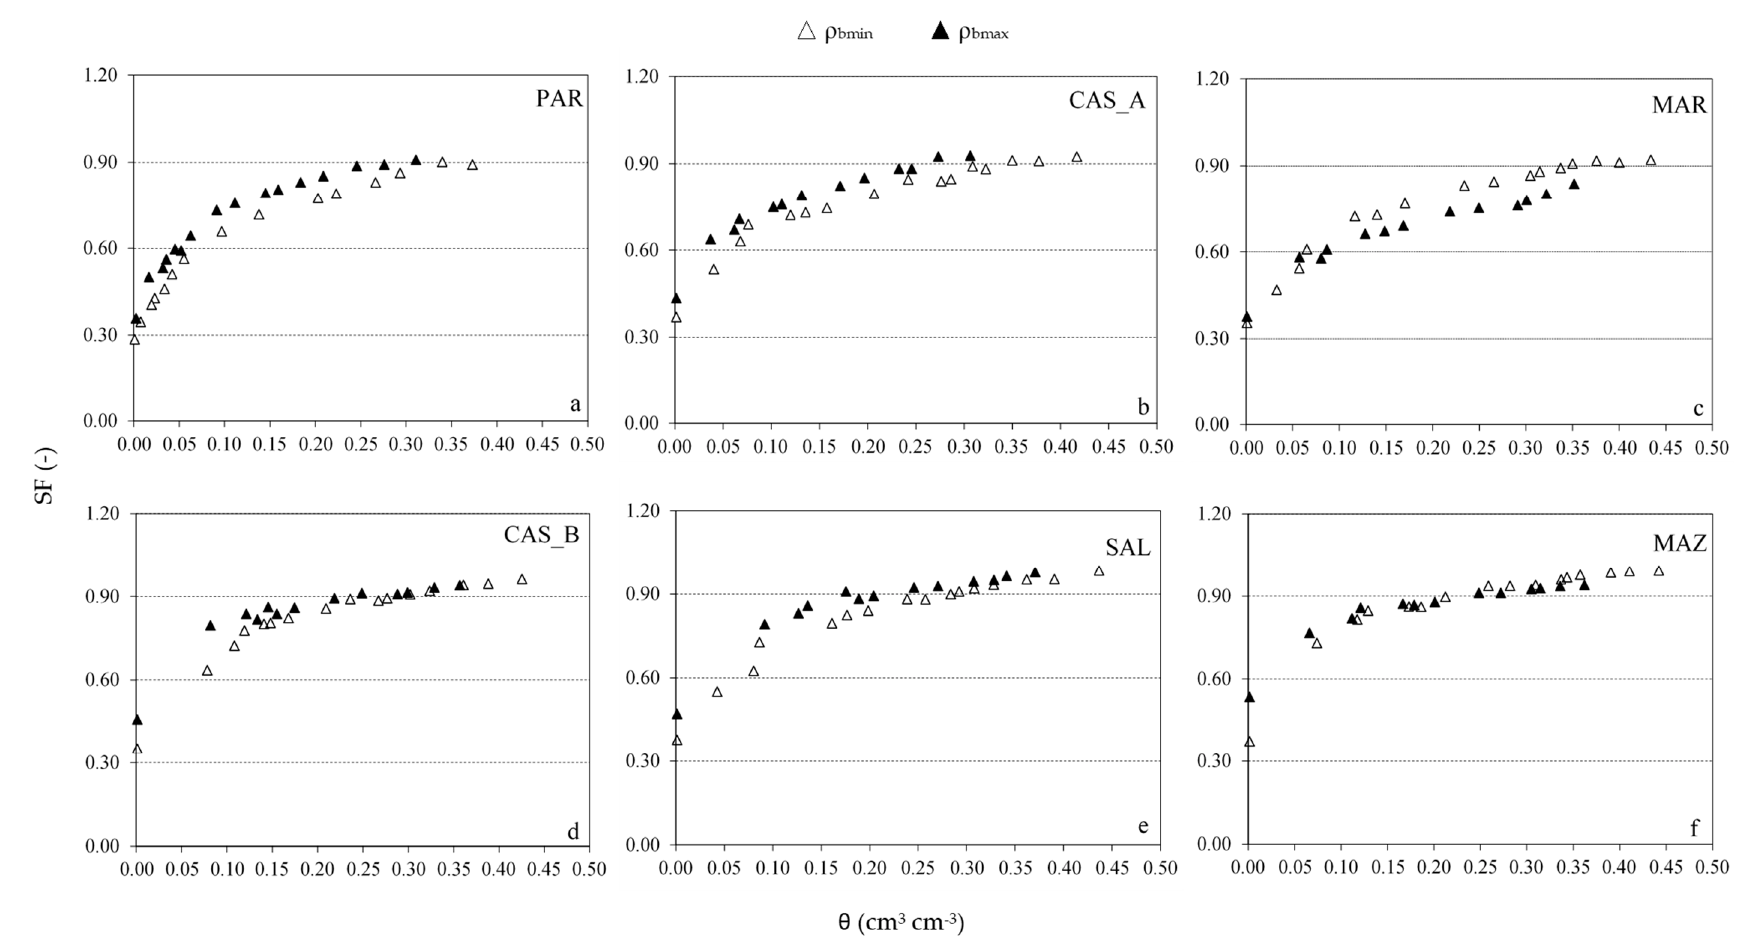
Figure 5. Relationships between scaled frequency, SF, measured by Diviner 2000 ® and volumetric water content, SF( θ ), for monoliths repacked at maximum ( (cid:78) ) and minimum ( (cid:52) ) bulk density. ( a ) PAR, ( b ) CAS_A, ( c ) MAR, ( d ) CAS_B, ( e ) SAL and ( f ) MAZ.